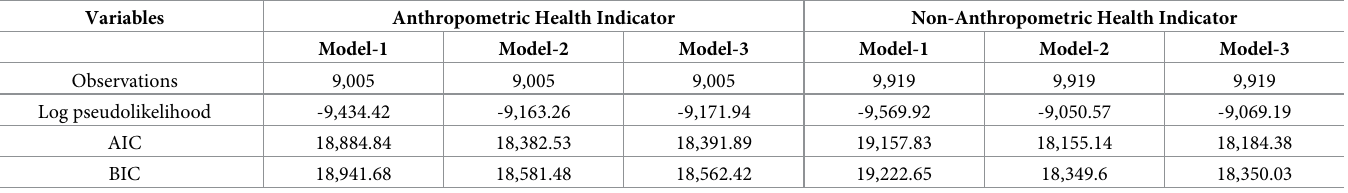
Table 5. The goodness of fit of the